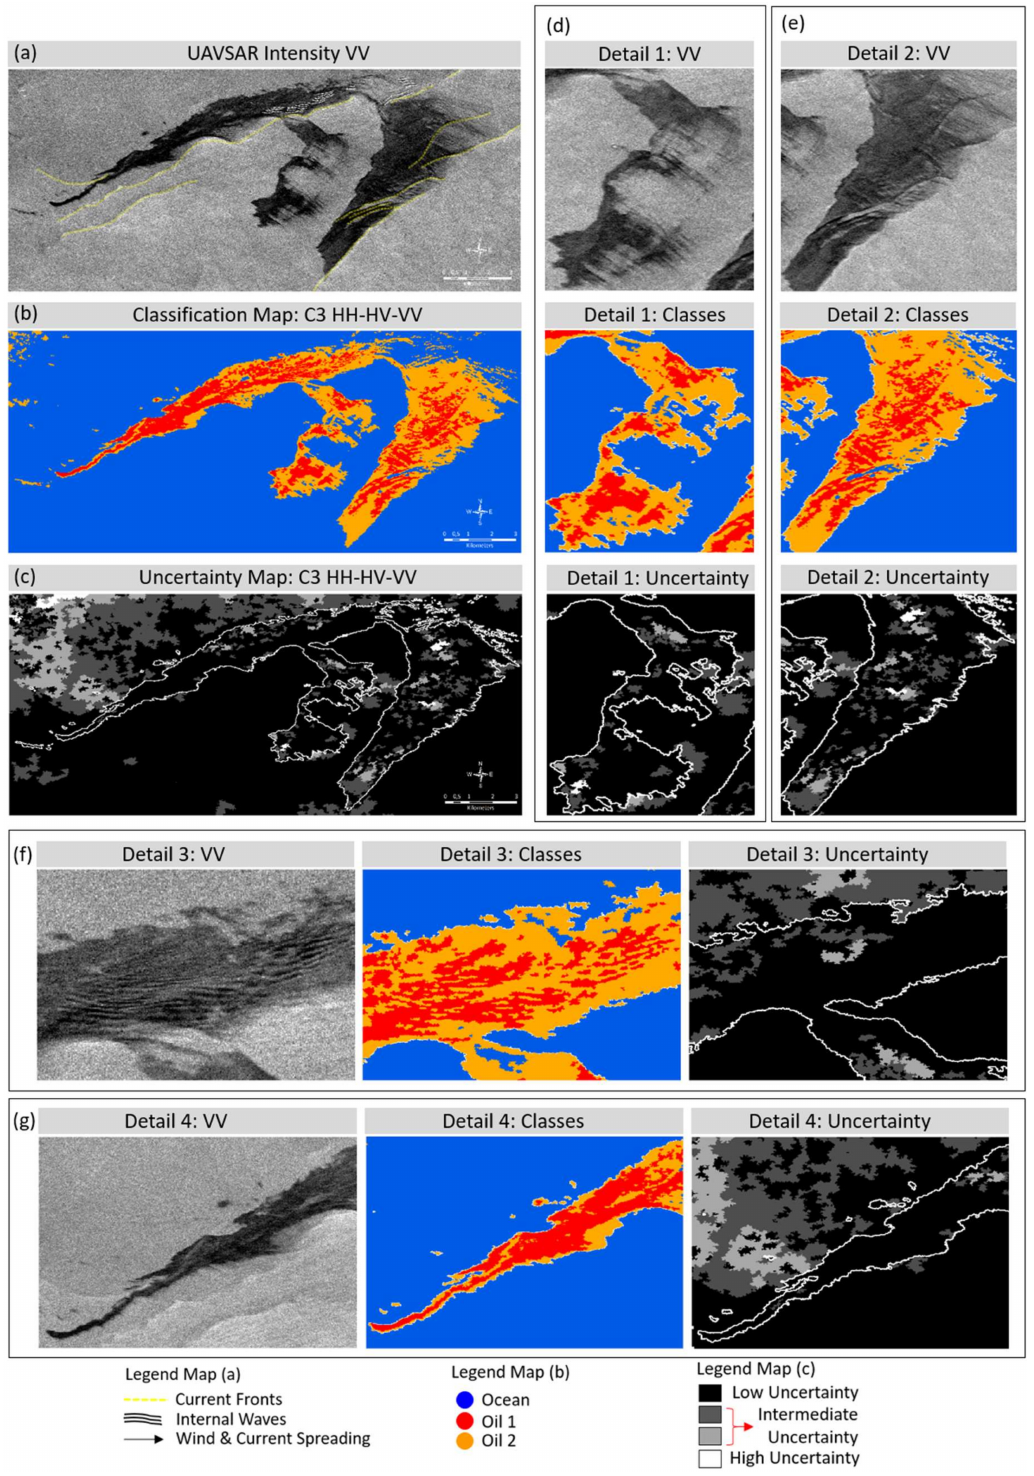
Figure 6. Classification results obtained by the covariance matrix (C3: HH-HV-VV): ( a ) Oil Slick study case; ( b ) Classification map; ( c ) Uncertainty map; ( d – g ) three image regions in